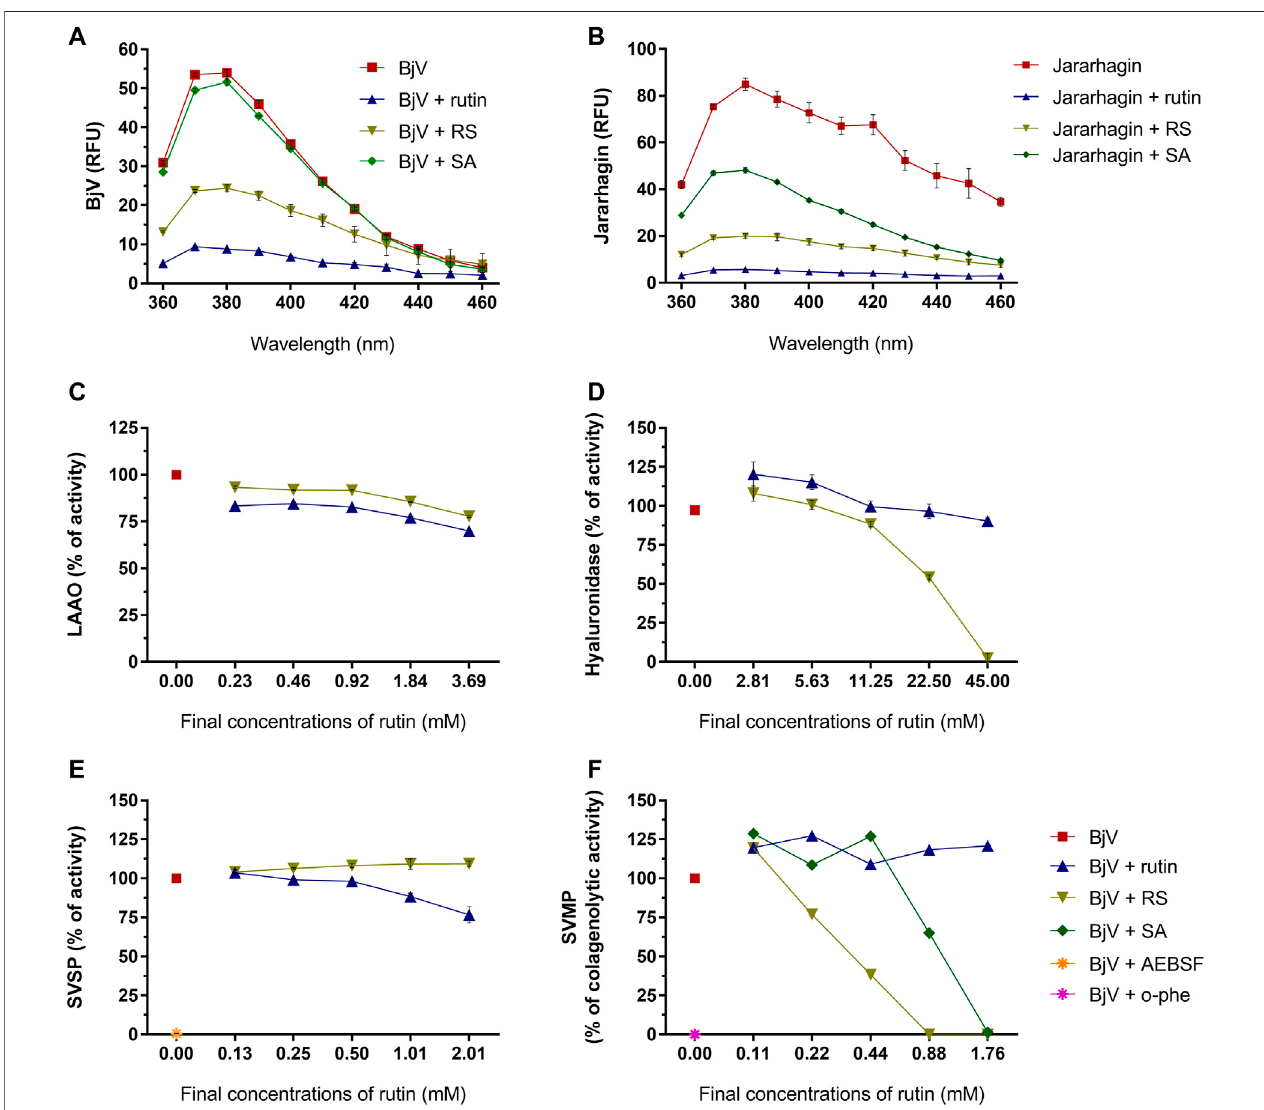
FIGURE 7 | Activity of rutin, RS and SA on the fl uorescence spectra of (A) BjV and (B) jararhagin. Data were expressed as RFU. Activity of rutin, RS, SA, AEBSF (SVSP inhibitor) and o-phe (SVMP inhibitor) on enzymatic activities of BjV protein families in vitro : (C) LAAO, (D) hyaluronidase, (E) SVSP and (F) SVMP. SA and o-phe were tested only for SVMP activity, and AEBSF was tested only for SVSP activity. Data were expressed as percentage of the maximum enzymatic activity; assays were carried out in duplicates/triplicates.